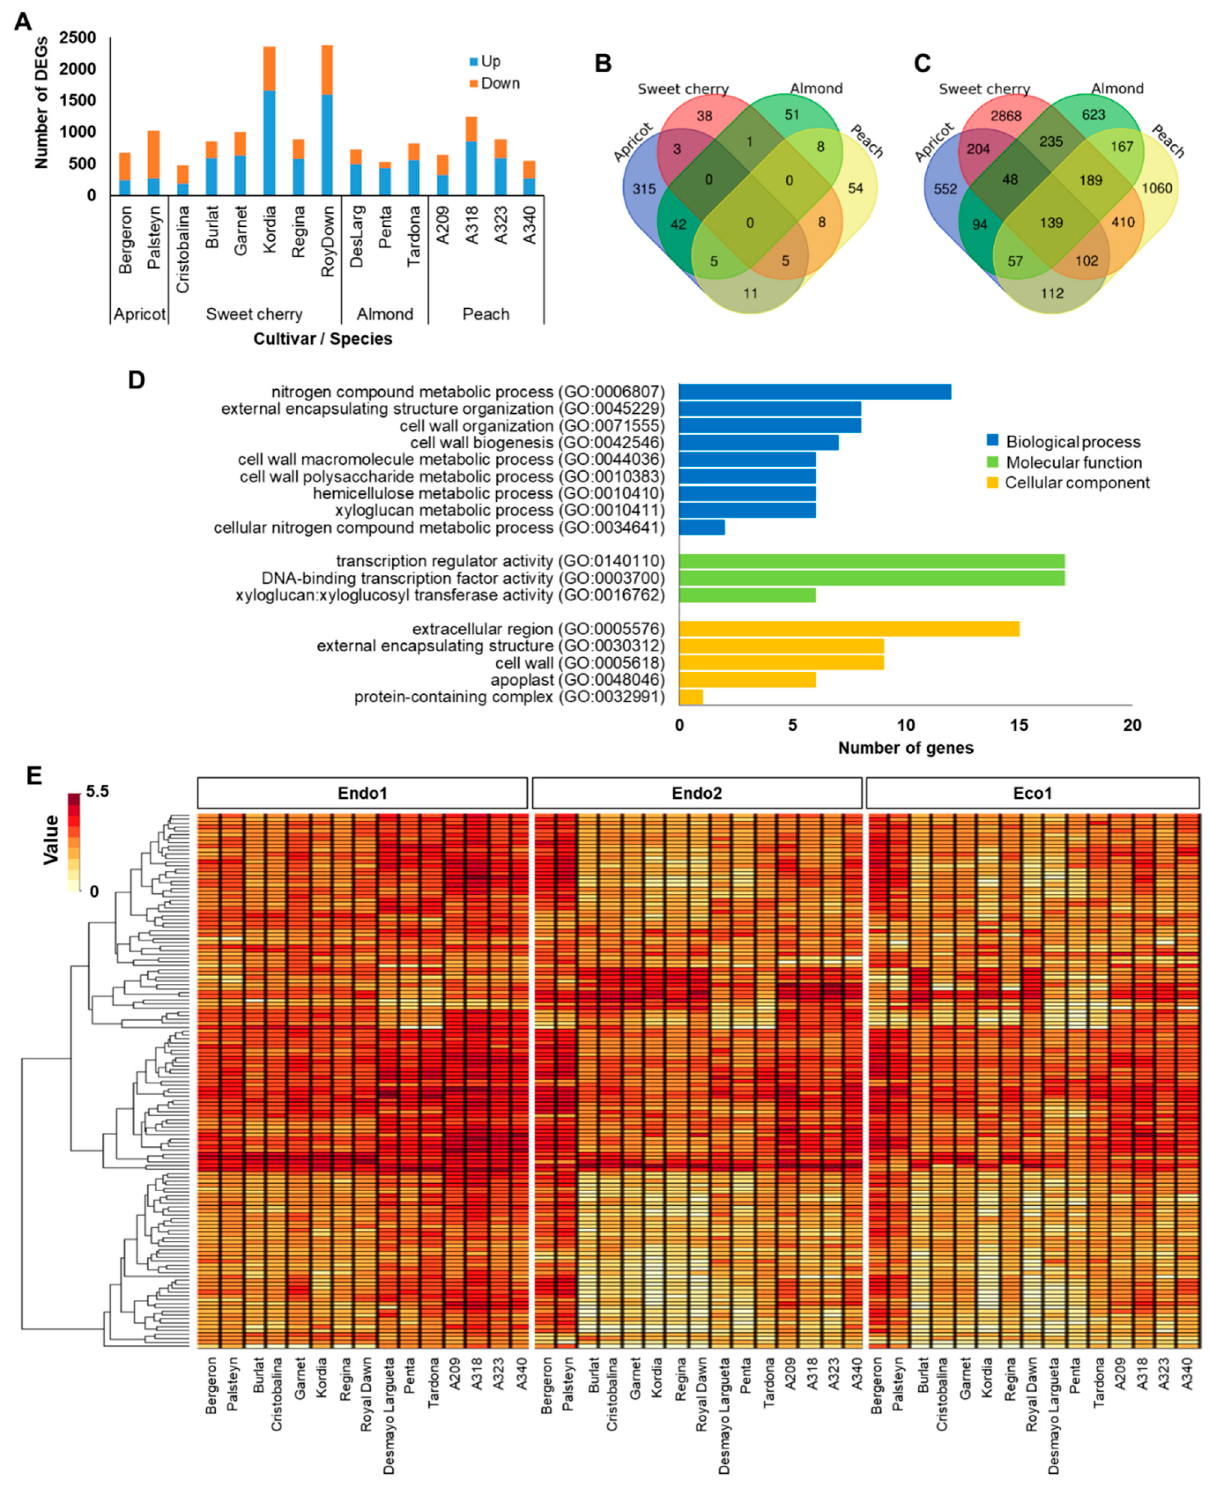
Figure 1. Summary of endodormancy-related genes. ( A ) Number of differentially expressed genes (DEGs) in each cultivar. ( B ) Venn diagram of common DEGs in all apricot, almond, peach, and sweet cherry cultivars. ( C ) Venn diagram of common DEGs in at least one cultivar of each species. ( D ) Enrichments in gene ontology terms for biological process, molecular function, and cellular component of common DEGs in at least one cultivar of each species. ( E ) Heatmap of the 139 commonly DEGs in at least one cultivar of each species during dormancy.